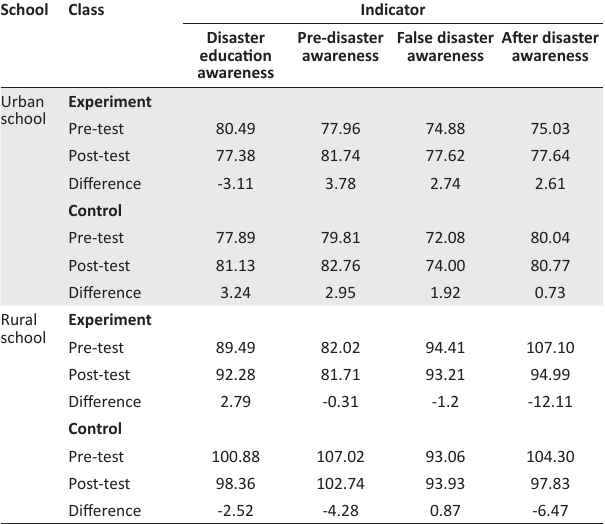
TABLE 8: Average of student disaster awareness score on the rural school each indicator.